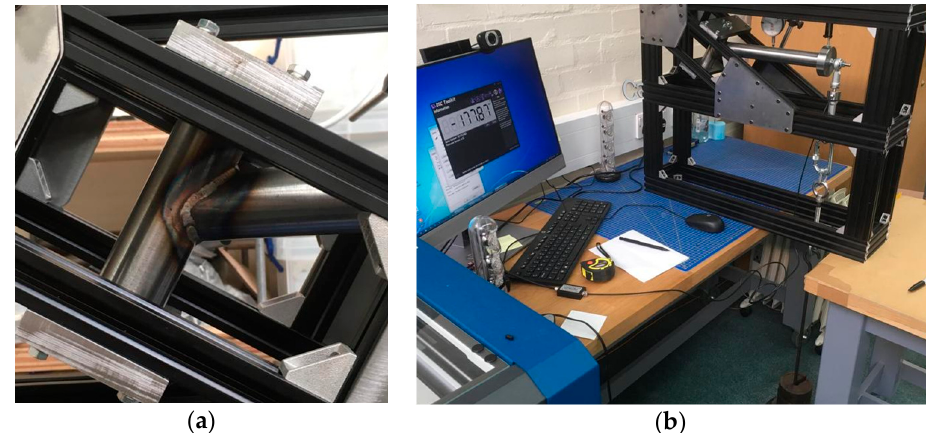
Figure 4. The authors have developed a prototype test rig that will allow for welded and brazed bicycle frame joints to be tested for their static and fatigue strengths: ( a ) the method of fixation using a set of customised expanding arbors; ( b ) loads can be applied using hung masses or stepper motor or pneumatic